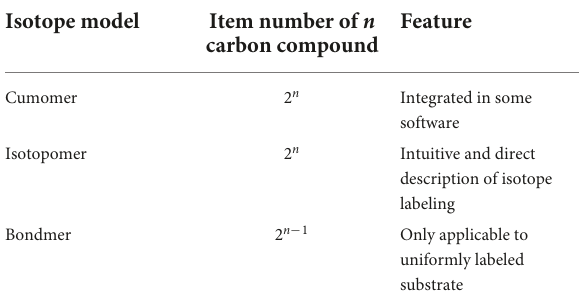
TABLE 2 Comparison of different isotope